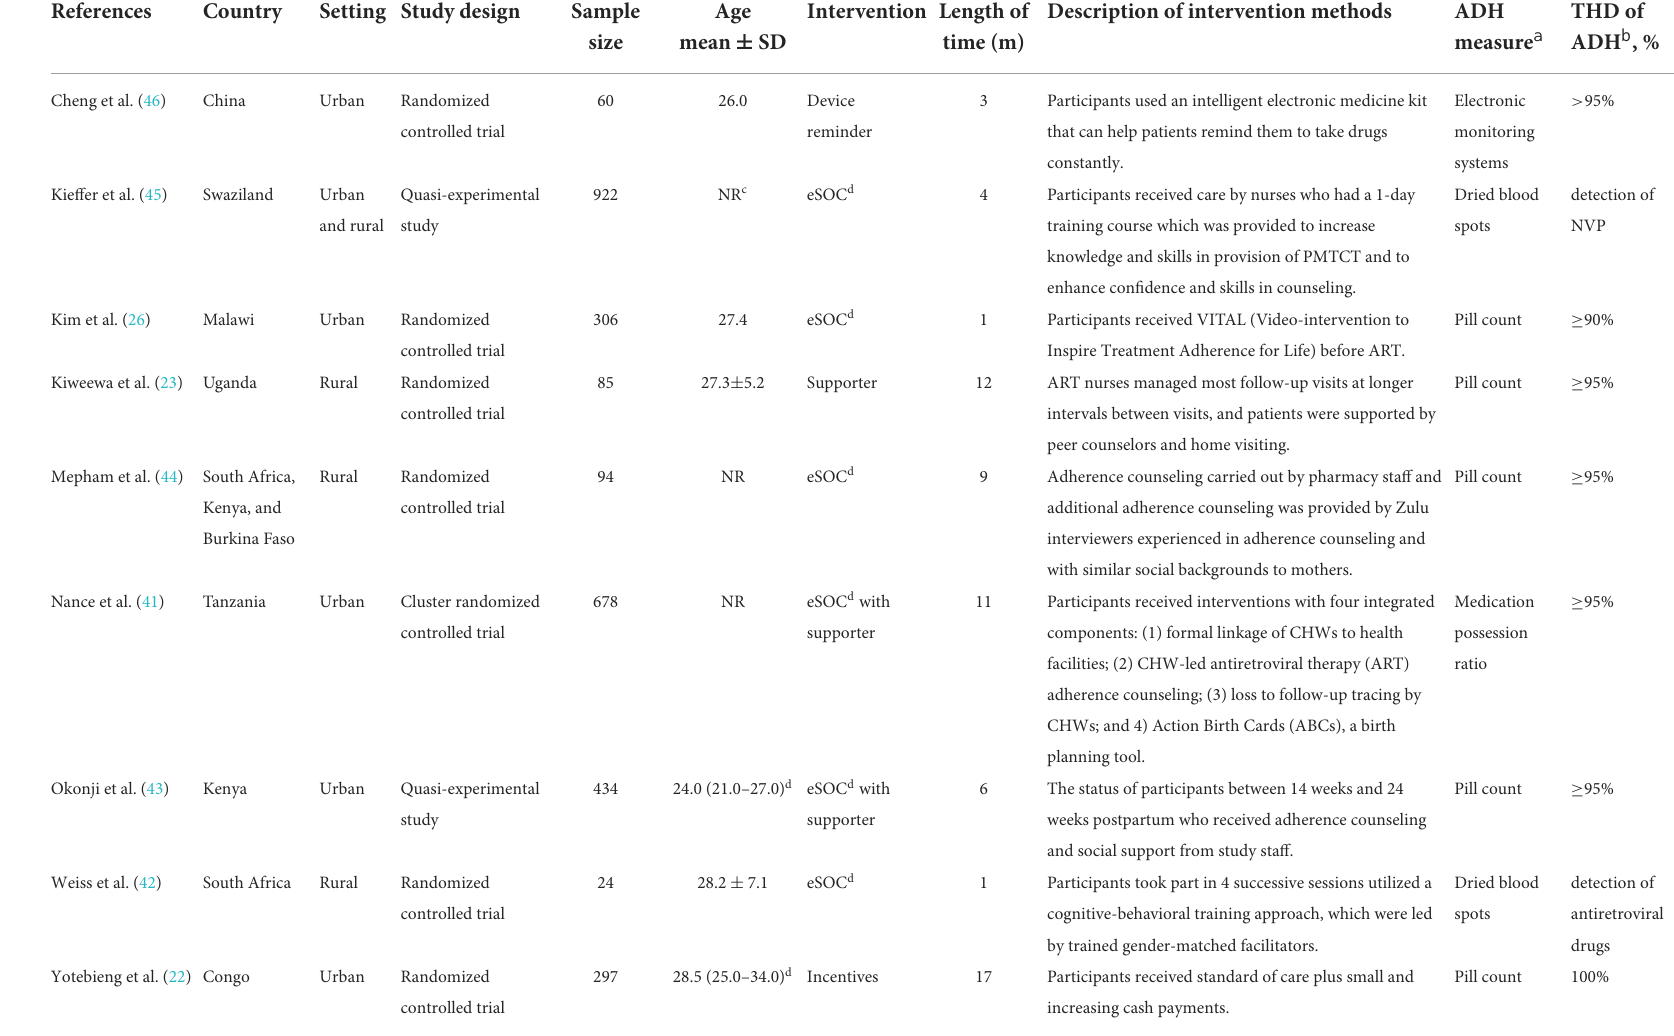
TABLE 1 Characteristics of studies included ( N =